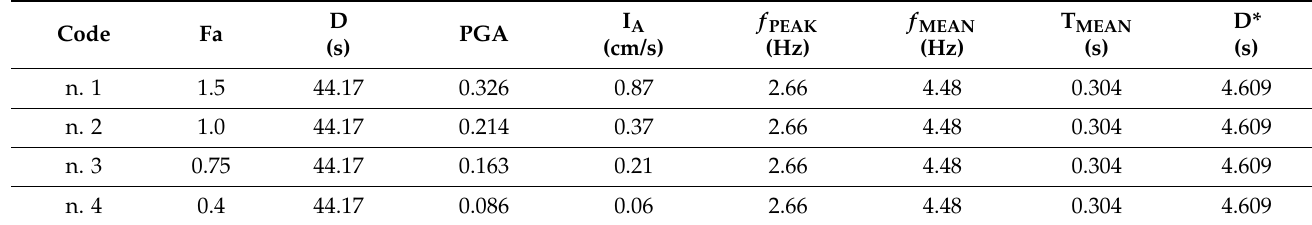
Table 1. Summary of the main features of the considered seismic inputs.